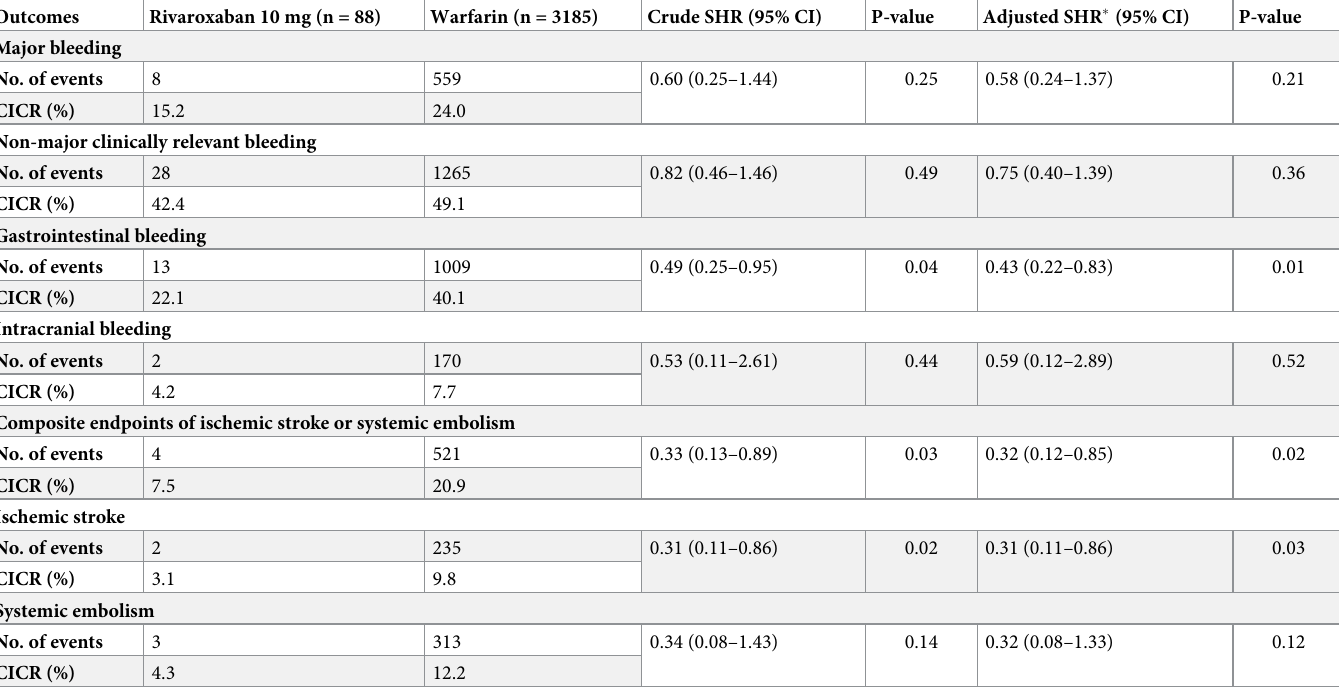
Table 3. Cumulative incidence and SHR of bleeding and thromboembolic outcomes: Rivaroxaban 10 mg versus warfarin.